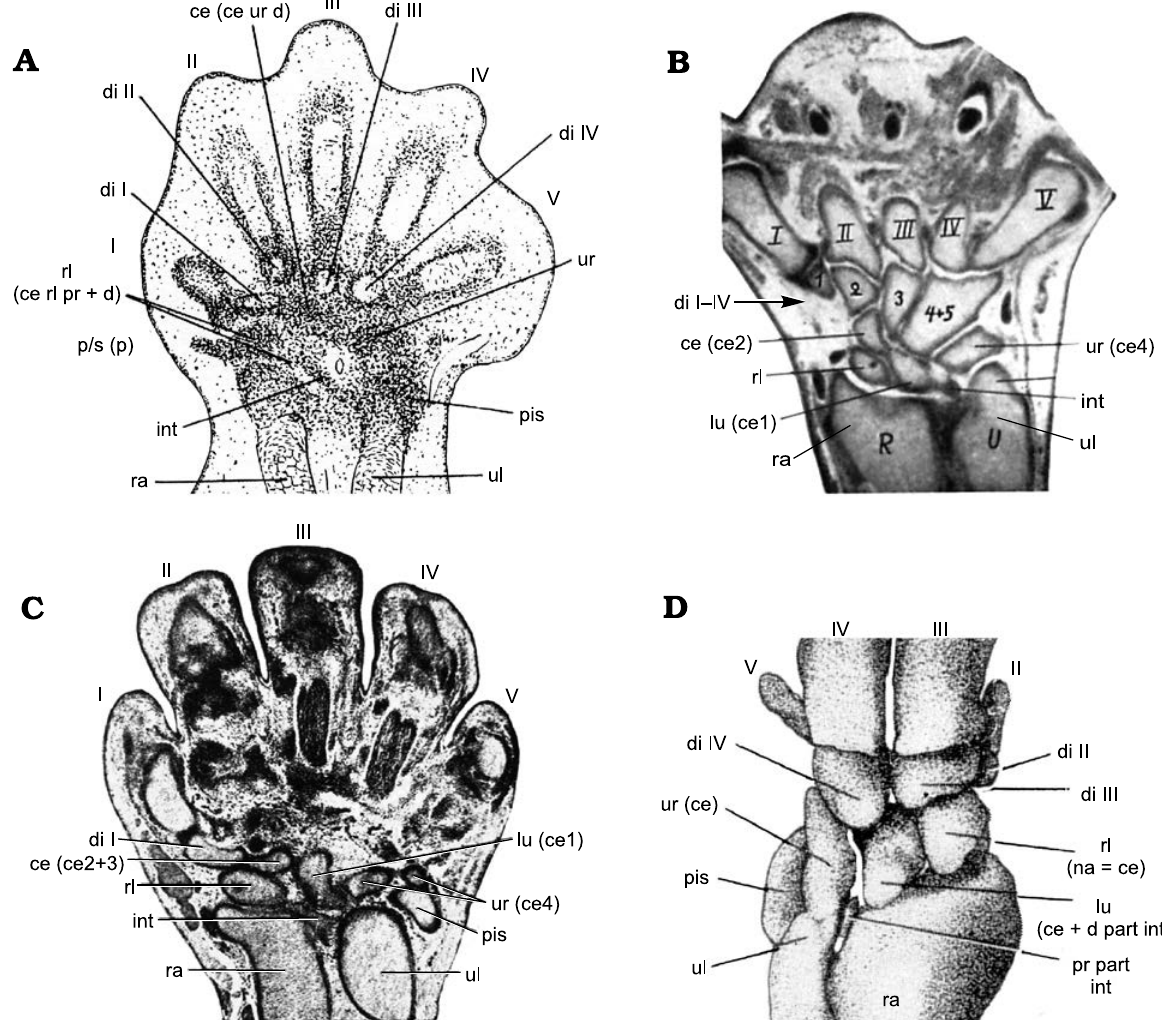
Fig. 14. Interpretation of the cartilaginous anlagen of the embryological carpus of different mammals by different authors. Whenever the radiale, ulnare or lunate have been interpreted previously as homologues of a centrale, the details are given in brackets following the abbreviations in the figures. A . Microcebus myoxinus Peters, 1852, 10.2 mm neck-rump length (from Schmidt-Ehrenberg 1942: 61, fig. 10, courtesy of Revue Suisse de